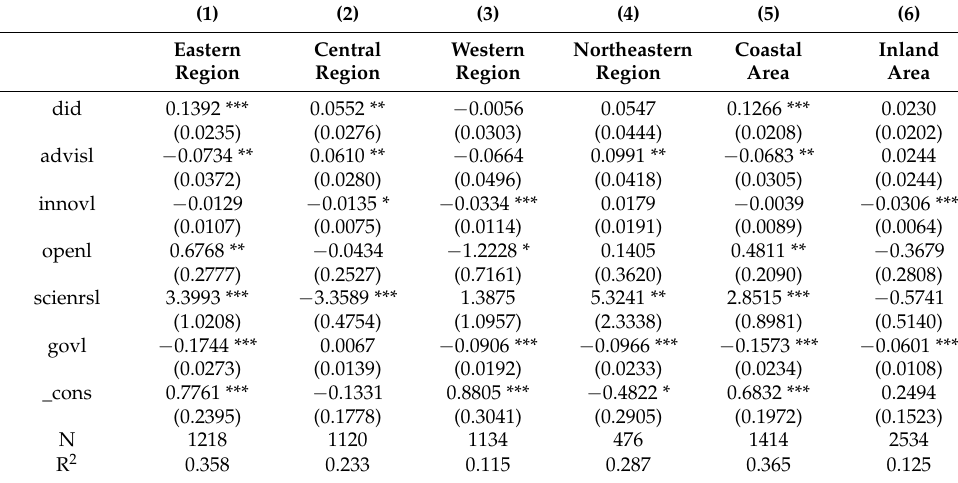
Table 8. The results of regional heterogeneity